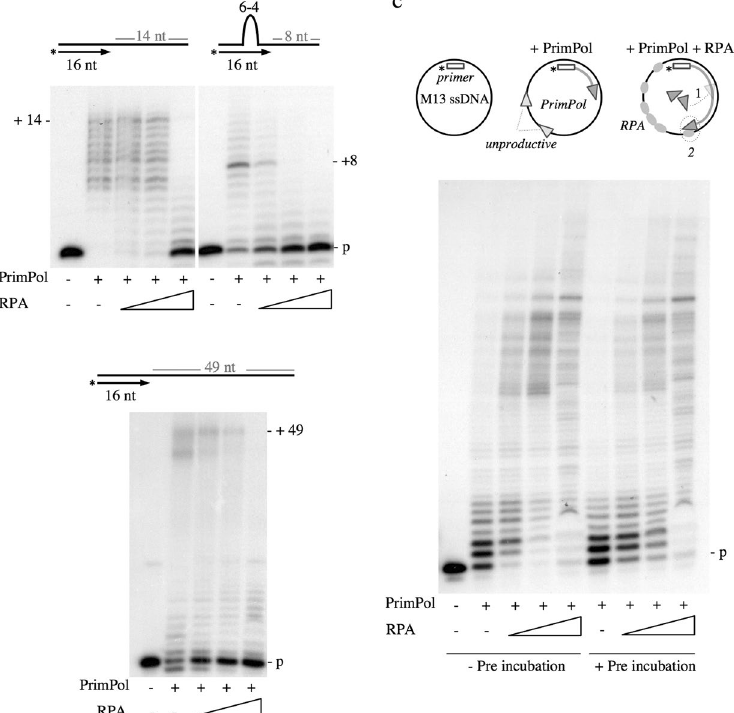
Figure 1. Modulation of PrimPol polymerase activity by RPA. ( a ) Effect of RPA on PrimPol polymerase activity on a short template/primer structure (30-mer/16-mer), either with an undamaged control template (left panel) or with a template containing a thymine dimer 6-4 photoproduct (right panel). PrimPol (200 nM) was incubated either alone or with RPA (12, 50 and 200 nM) in buffer R supplemented with 100 µ M dNTPs and 2 nM labeled DNA. ( b ) Effect of RPA on PrimPol polymerase activity on a longer template/primer structure (65-mer/16-mer). PrimPol (200 nM) was incubated either alone or with RPA (12, 50 and 200 nM) in buffer R supplemented with 100 µ M dNTPs and 2 nM labeled DNA. ( c ) Effect of RPA on PrimPol polymerase activity on circular M13 ssDNA annealed to a labeled oligonucleotide. PrimPol (200 nM) and RPA (20, 100, 500 nM) when indicated, were incubated with dNTPs (100 µ M), 5 mM MgCl 2 and 1 mM MnCl 2 as metal cofactors, and primed-M13 ssDNA (2.5 nM). When indicated, PrimPol and RPA were pre-incubated 10 min at RT before template/primer addition. This experiment has been repeated more than 3 times, showing the same effect in all cases. The scheme represents the stimulation of PrimPol polymerase activity when increasing concentrations of RPA are added to the reaction when ssDNA is covered by RPA, PrimPol molecules cannot be unproductively bound, but form a recycling pool to fuel binding and extension of the primer (1); besides, a specific PrimPol/ RPA association (2) can directly enhance the rate and processivity of